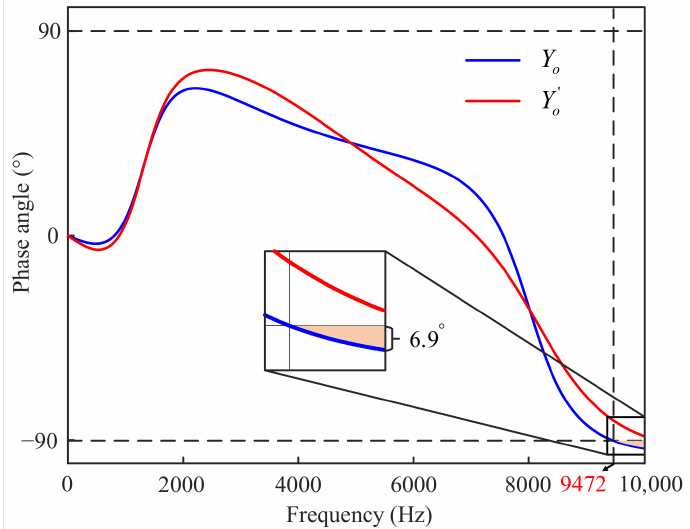
Figure 13. Phase diagrams of the output admittance before and after using the PLC.